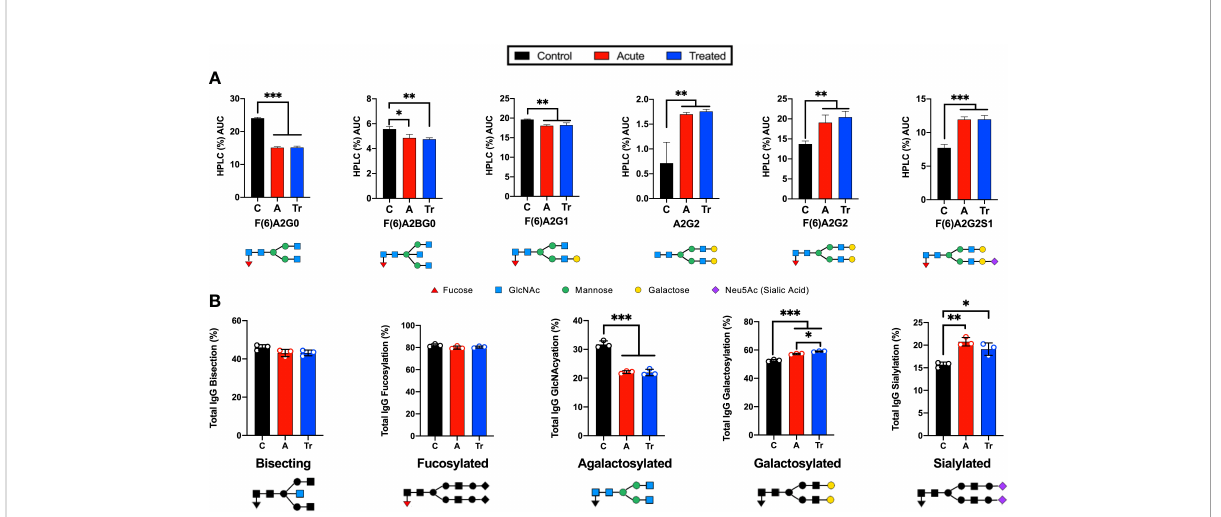
FIGURE 1 Analysis of IgG reveals signi fi cant changes in N-glycan structure distribution during acute and treated LD. (A) Signi fi cant alterations of IgG N- glycans reported by HPLC analysis from pooled serum from control (C), acute (A), or treated (Tr) patients reported as the percent area under the curve (AUC) for each peak determined from the average of triplicate samples. N-glycan structures are displayed below. Control represents pooled healthy age-matched serum n=7, Acute represents pooled serum from two-tiered diagnosed Lyme disease patients n=5, Treated represents patients donating serum a second time 70-90 days after completion of the reportedly curative round of antibiotic treatment (14-21d doxycycline) for Lyme disease n=3. (B) Labeled N-glycan classes: Bisecting, Fucosylated, Agalactosylated, Galactosylated, Sialylated detected using HPLC analysis of IgG N-glycans from 3 replicates +/- S.D. Analysis was completed using One-Way ANOVA with post-hoc Tukey ’ s multiple comparisons, *p<0.05, **p<0.01,